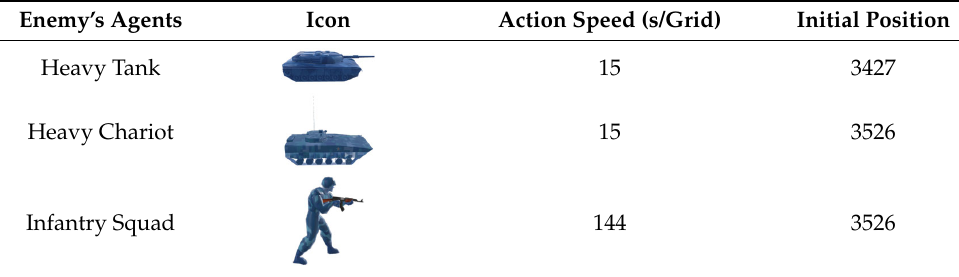
Table 4. The agents‘ action.